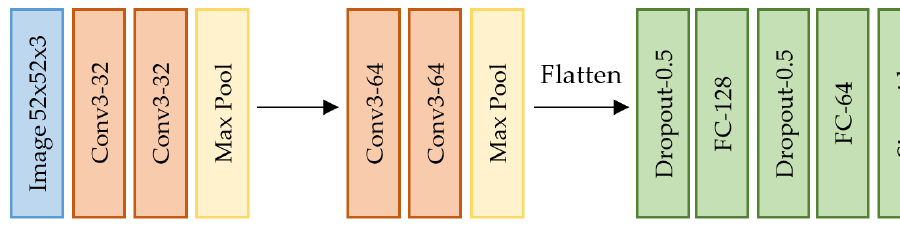
Figure A2. CNN classifier architecture.